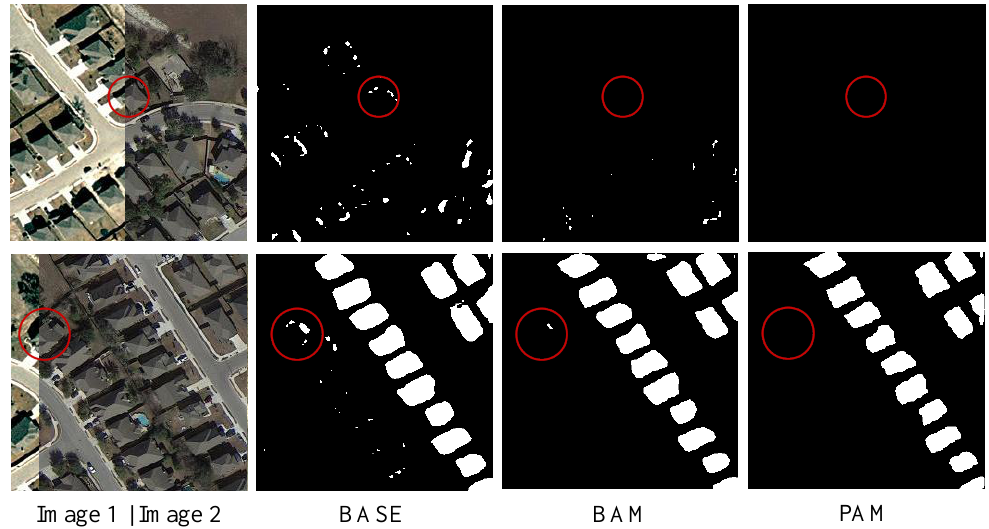
Figure 7. Visualization results of our ablation experiments on the samples suffering from misregistration errors. To visualize the misregistration errors, we stitch the two images. We use red circles to highlight the misregistration